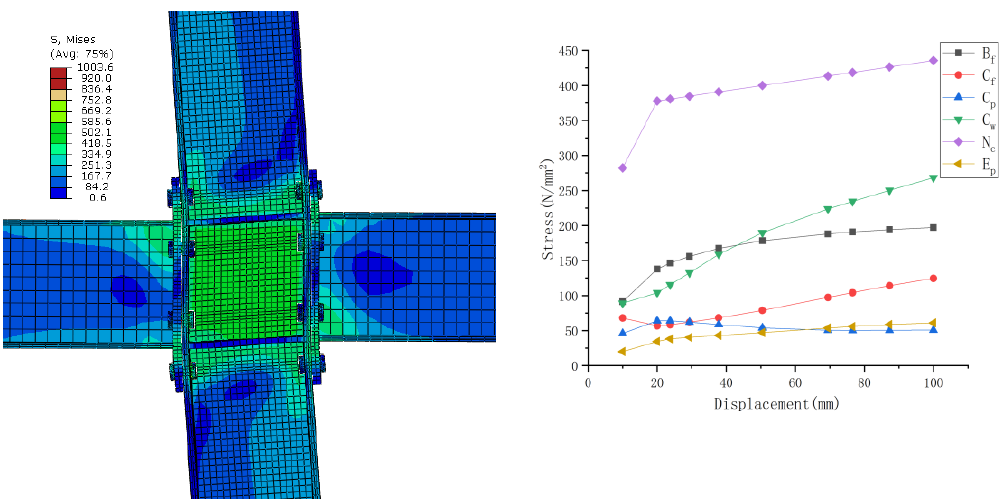
Figure 11. Stress distribution and stress history at specified points of a 10-mm end-plate.